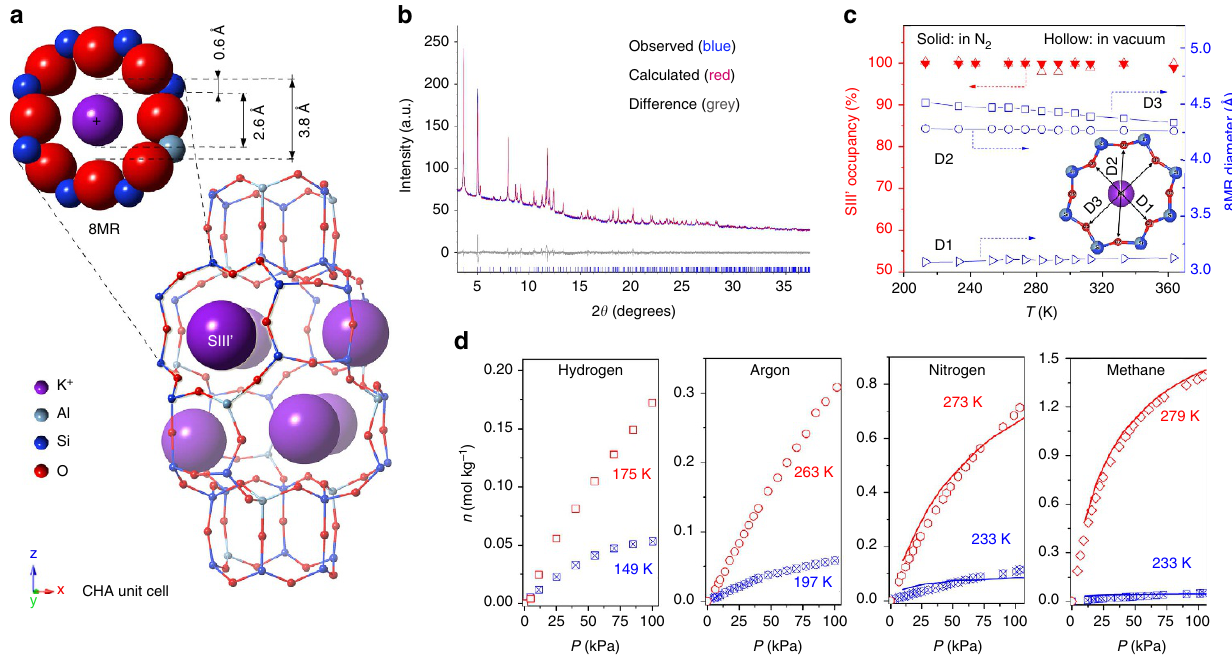
Figure 1 | Paradox of non-polar gas molecule admission through the apparently blocked pores of a potassium chabazite. ( a ) Illustration of the structure of an ideal potassium chabazite crystal, highlighting the eight-membered oxygen ring (8MR) which sets the nominal pore aperture diameter to be 3.8Å (distance between opposing oxygen atoms). The centre of the 8MR pore aperture (cation site SIII 0 ) is occupied by the potassium cation, reducing the nominal accessible pore aperture to 0.6Å, as determined from the Synchrotron PXRD data. ( b ) Rietveld refinement of a representative Synchrotron PXRD pattern for trapdoor potassium chabazite with a Si/Al ratio of 2.2 ( r2 KCHA). ( c ) Left axis: fractional occupancy of SIII 0 sites by K þ cations indicating blockage of 8MR pores over the experimental temperature range. Estimated uncertainty 1.5%. Right axis: evolution of the 8MR dimensions D1, D2 and D3 (inset) of r2 KCHA suggesting pore contraction with increasing temperature, ruling out the possibility of thermally induced pore dilation. 0.3% uncertainty. ( d ) Adsorption isotherms for hydrogen, argon, nitrogen and methane, respectively, on r2 KCHA showing restricted pore accessibility at low temperatures (crossed blue symbols) but no restriction at high temperatures (red open symbols), and comparison with GCMC calculated equilibrium capacities (lines) for nitrogen and